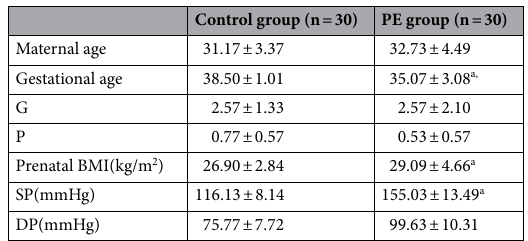
Table 6. Baseline characteristics of the women included in this analysis. a Compared with the control group P < 0.05. Comparison between two groups was conducted by the independent sample t-test.